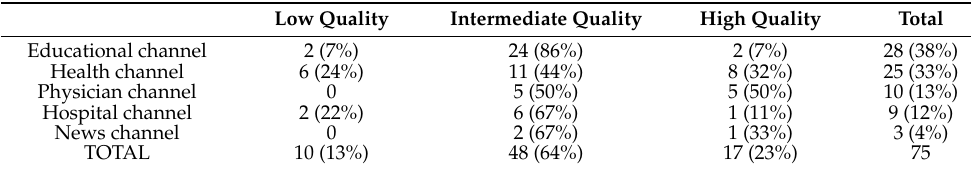
Table 3. The GQS scores according to the source of the video uploaders.